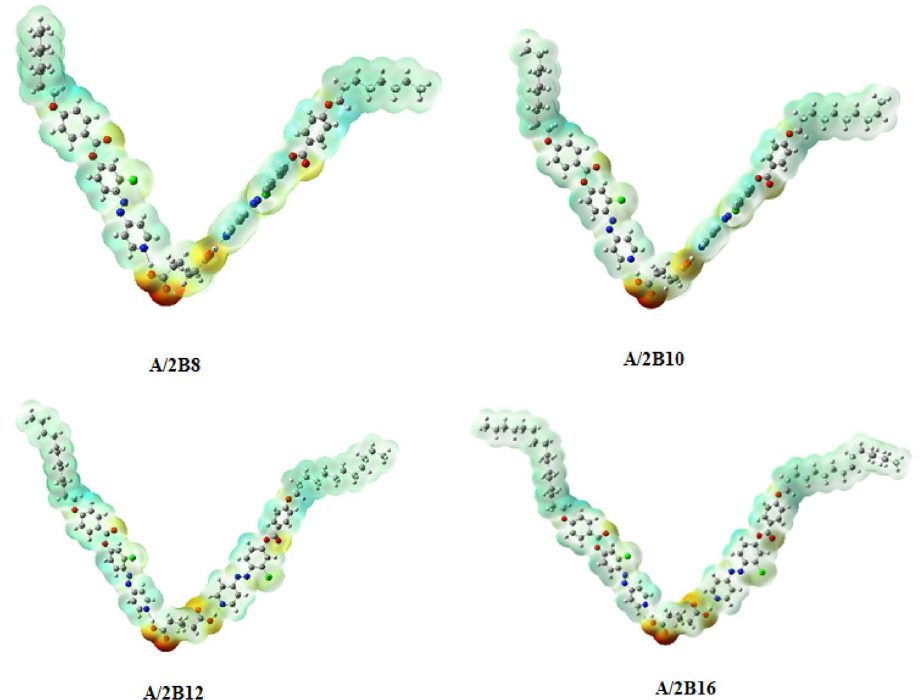
Figure 10. MEP for present H-bonded complexes, A/2Bn